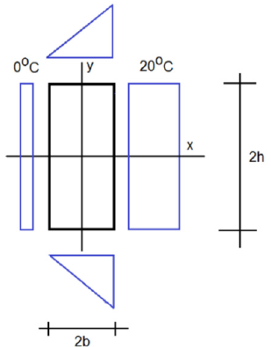
Figure 7. Steady ‐ state temperature on the edges of Plate 2.